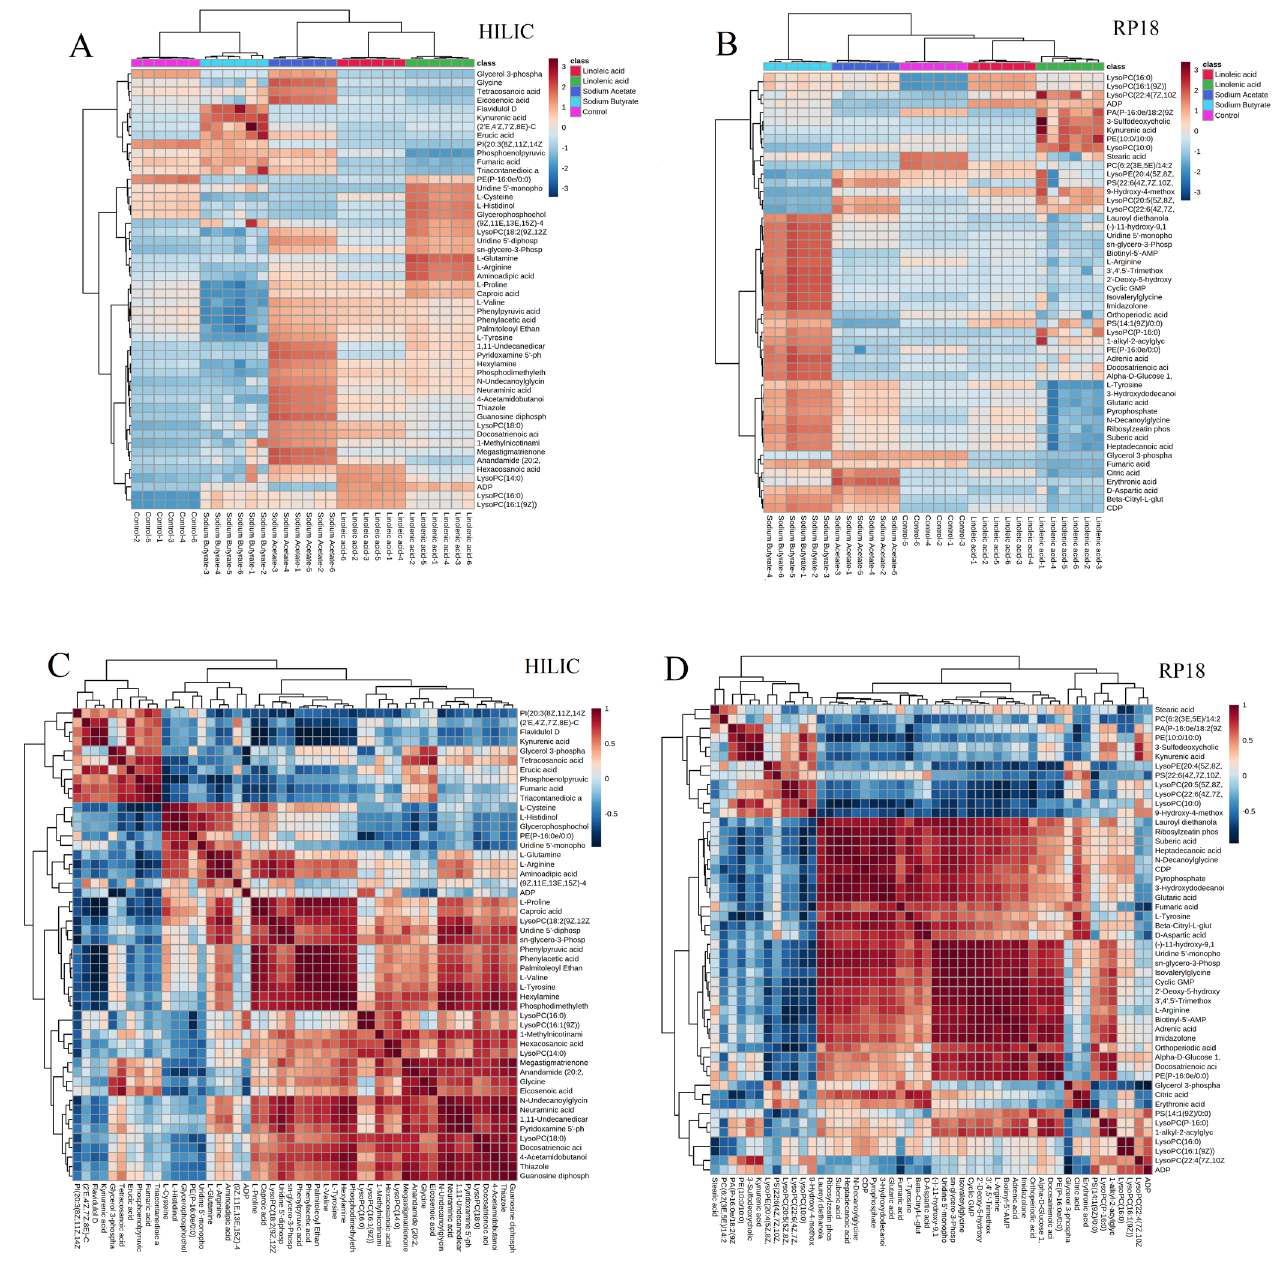
Figure 3. Heatmaps and correlation analysis depending on untargeted metabonomics: ( A ) heatmap based on HILIC untargeted metabonomics, ( B ) heatmap depending on RP-18 untargeted metabo- nomics, ( C ) correlation analysis based on HILIC untargeted metabonomics, and ( D ) correlation analysis depending on RP-18 untargeted metabonomics.